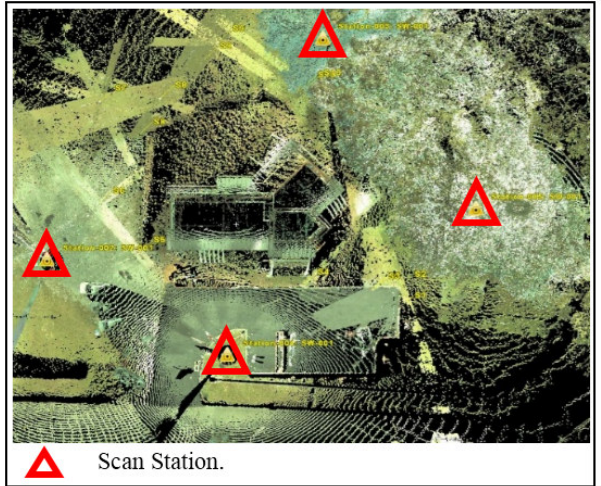
Figure 6. The different scan station scanning the façade of the Eco-home building.